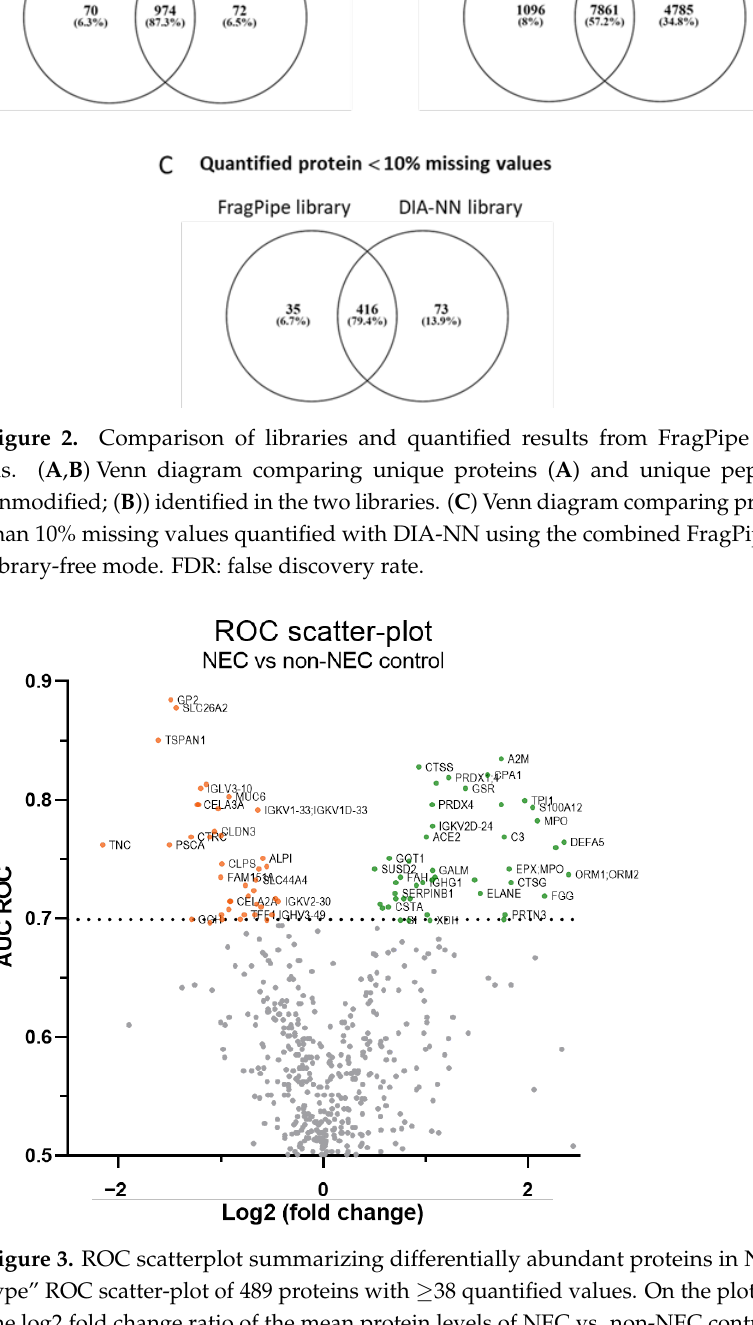
Figure 4. Gene ontology of the biological process. Gene ontology analysis of the 86 human genes associated with the 80 protein markers using the GO_BiologicalProcess-EBI-UniProt-GOA-ACAP- ARAP (22 – 04-2022) reference term database with the ClueGO (v.2.5.8) plug-in in the Cytoscape soft- ware (v.3.9.1). In total, 125 genes picked from 69 of the 86 genes were clustered between the eight main groups of biological process-related terms. On the pie chart, the groups are named based on their leading (most significant) term, and the size of the segment is defined by the % of associated genes per group calculated from the total picked genes. Group-corrected p value calculated by ClueGO with the Bonferroni step-down method: ** p < 0.001.